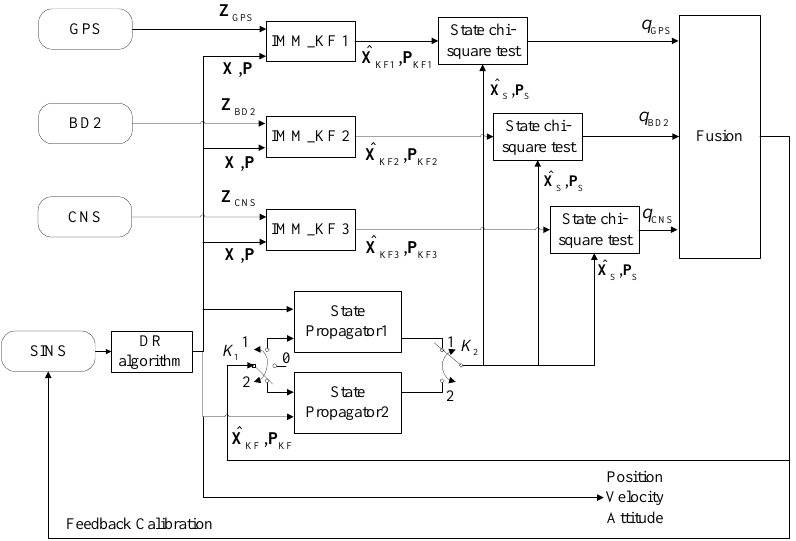
Figure 2. System architecture. SINS, Strap-down Inertial Navigation System; DR,